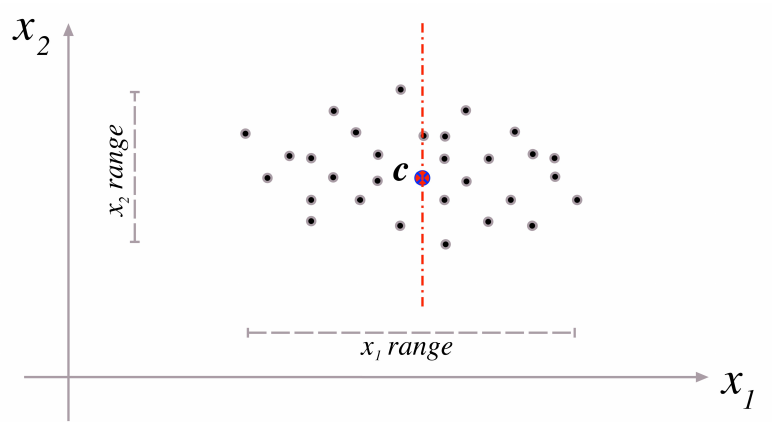
Figure 5. An example of cluster splitting in two